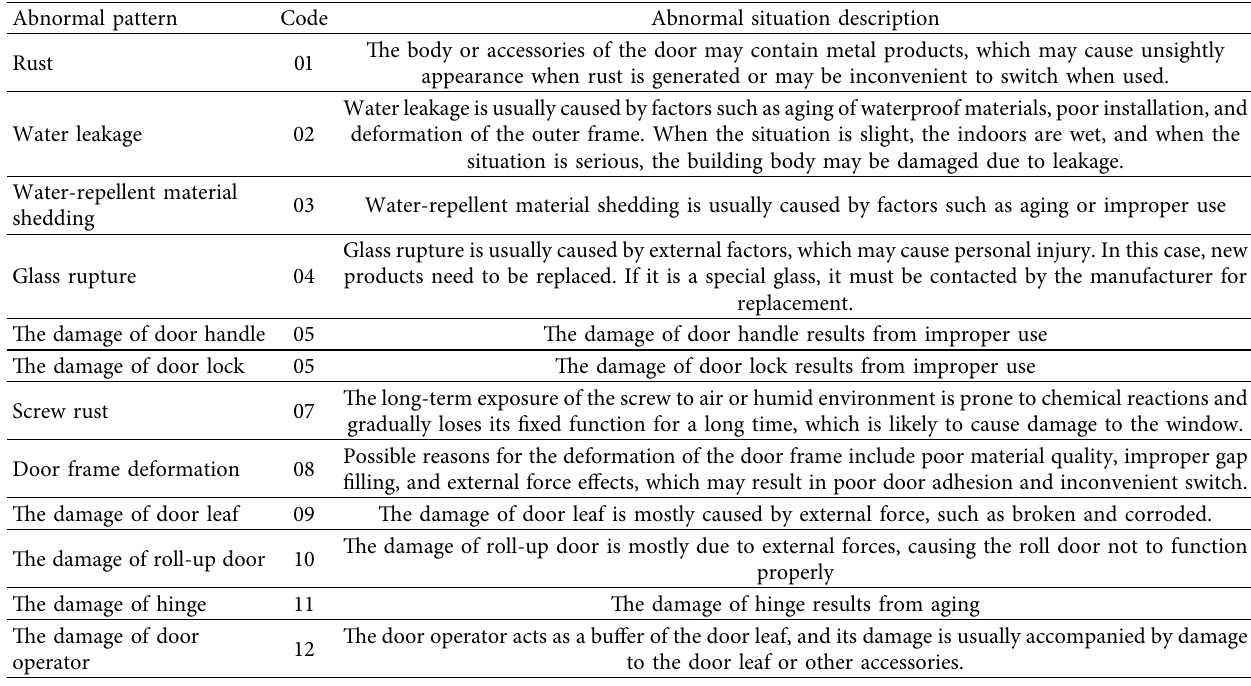
Table 4: Common abnormal patterns of the door